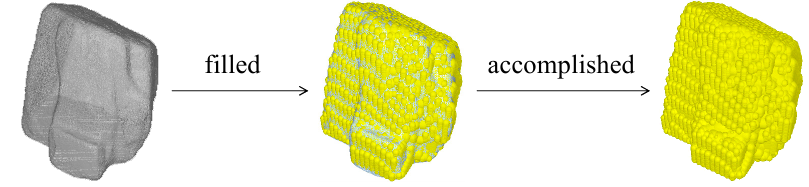
Figure 7. Particle modeling. Figure 7. Particle